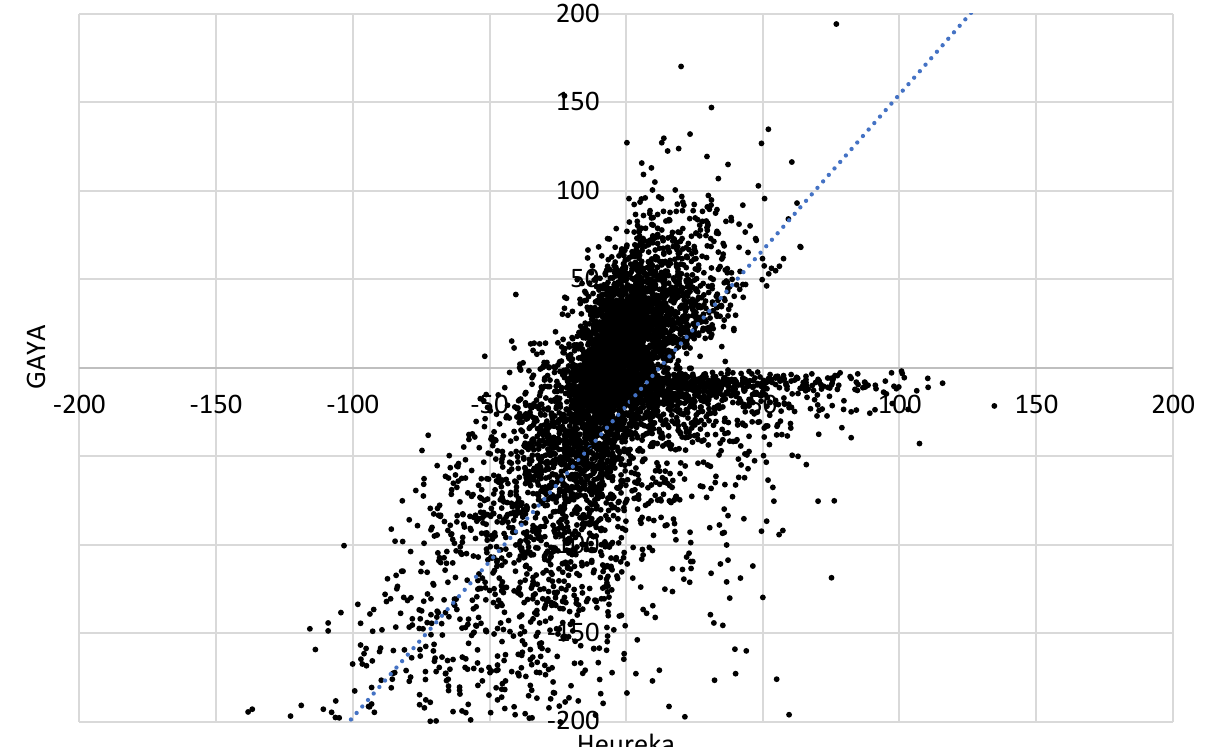
Figure 4. The change of number of stems ha − 1 for five years from current state, GAYA vs. Heureka.